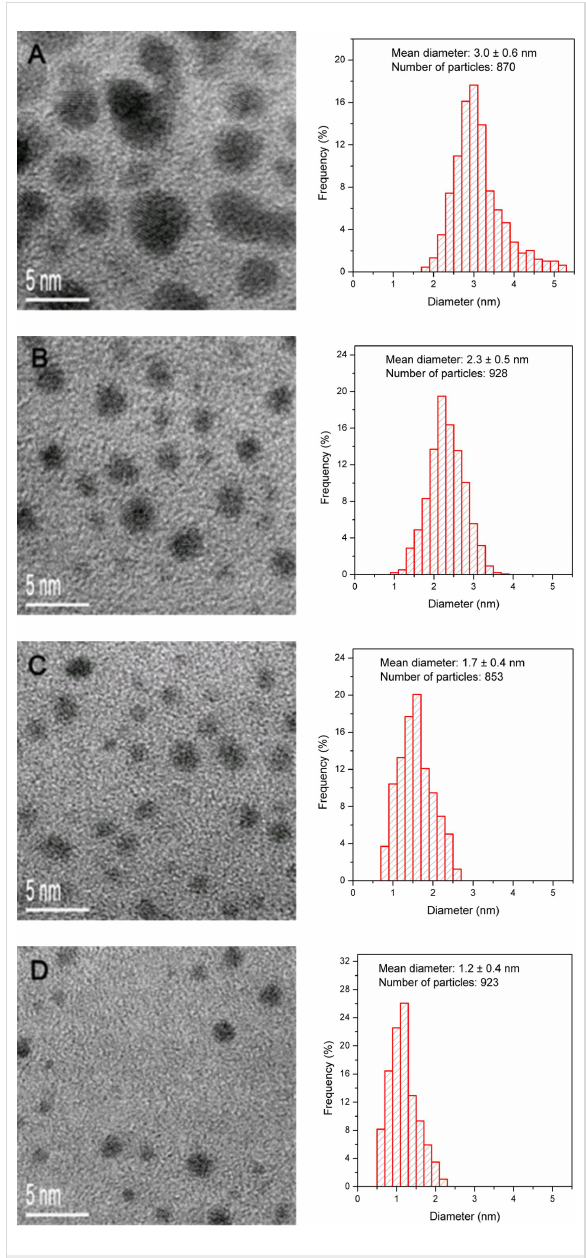
Figure 3: HRTEM images and size histograms of the sequential size- selected fractions (A) F 36% , (B) F 54% , (C) F 72% , and (D) F 90% .